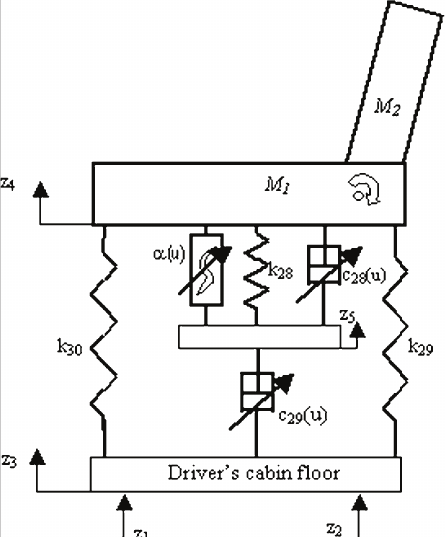
–k /; Table 5: 17 27